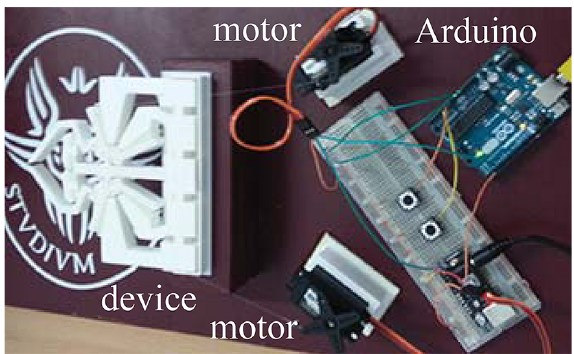
Figure 6. A picture of the experimental layout (second